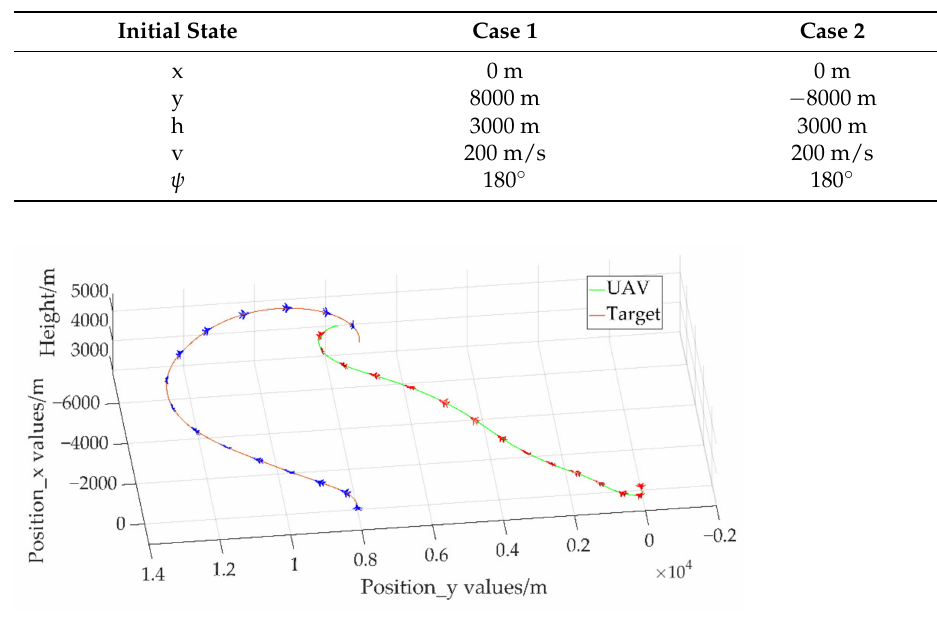
Figure 7. Air combat three-dimensional trajectory of two aircraft in case 1.